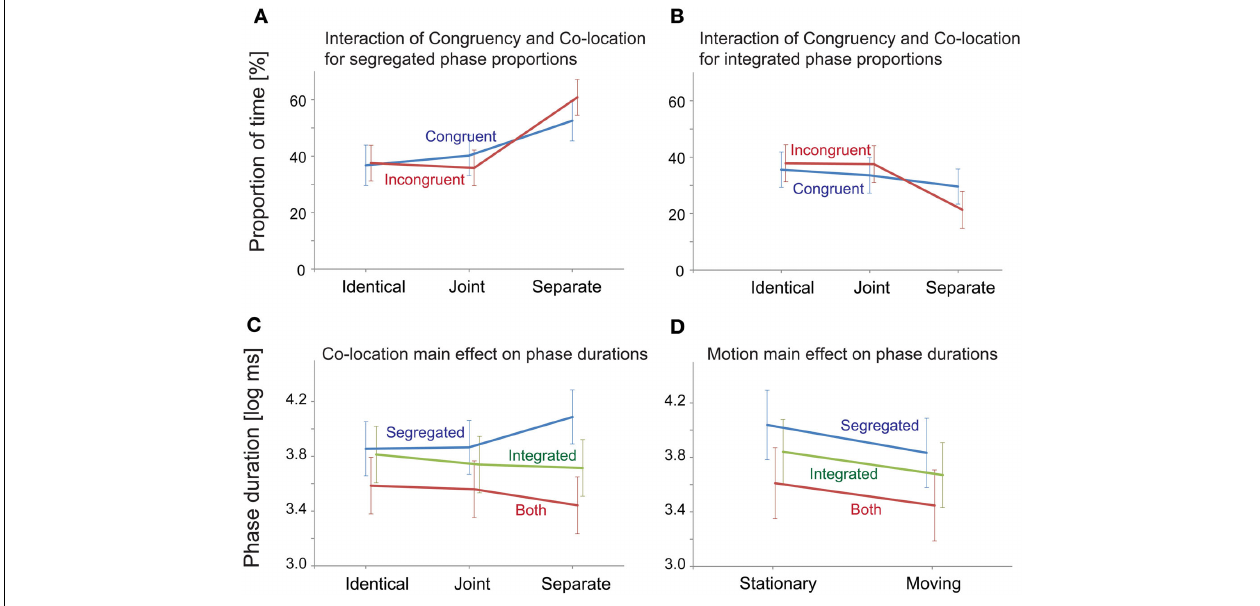
FIGURE 5 | Significant ANOVA effects for “Integrated,” “Segregated,” and “Both” response alternatives. (A) Spatial separation increased the proportion of the “segregated” responses, this effect being larger with the Incongruent visual cues. (B) Spatial separation decreased the proportion of the “integrated” percepts, this effect being significant only with the